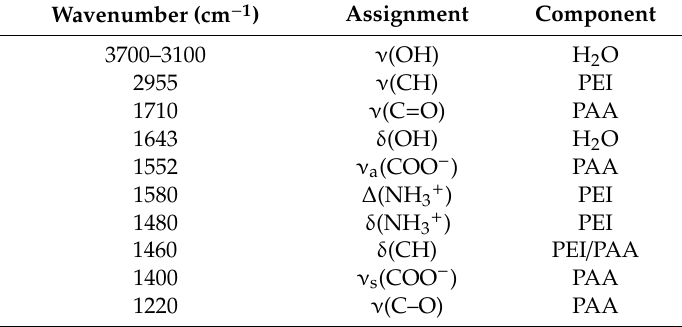
Figure 1. ATR-FTIR spectra of 1 M PEI (red) and 1 M PAA (blue) solutions at pH = 4 (respective lower spectrum) and pH = 10 (respective upper spectrum) at Si-IRE. PEI, PAA and H 2 O signals are indicated by red, blue and black arrows, respectively. Table 1. Assignment of IR bands appearing in FTIR spectra of 1M PEI and 1M PAA solution.